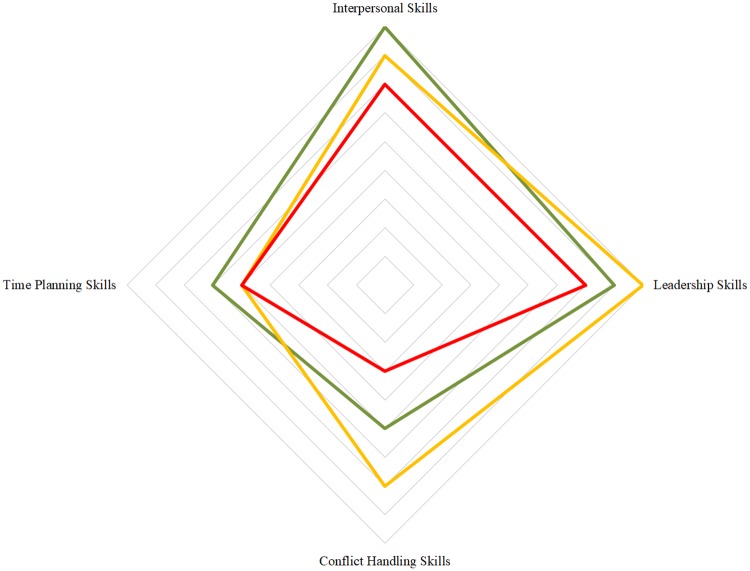
General management and leadership competencies among district health managers in high, mid and low performing districts.Red: Lowest performing districts (District 1 & 2), Yellow: Mid performing districts (District 3 & 4), Green: Highest performing districts (District 5 & 6). No statistical significant difference (p>0.05, oneway non-parametric test for trend); Interpersonal Skills: 2 items, Cronbach alpha 0.88, Time Planning Skills: 3 items, Cronbach alpha 0.86, Leadership Skills: 5 items, Cronbach alpha 0.9, Conflict Handling: 1 item.